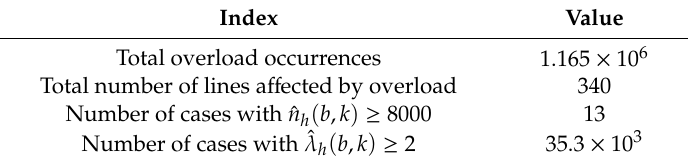
Table 7. Yearly network performances in N − 1 condition (lines in service–lines in